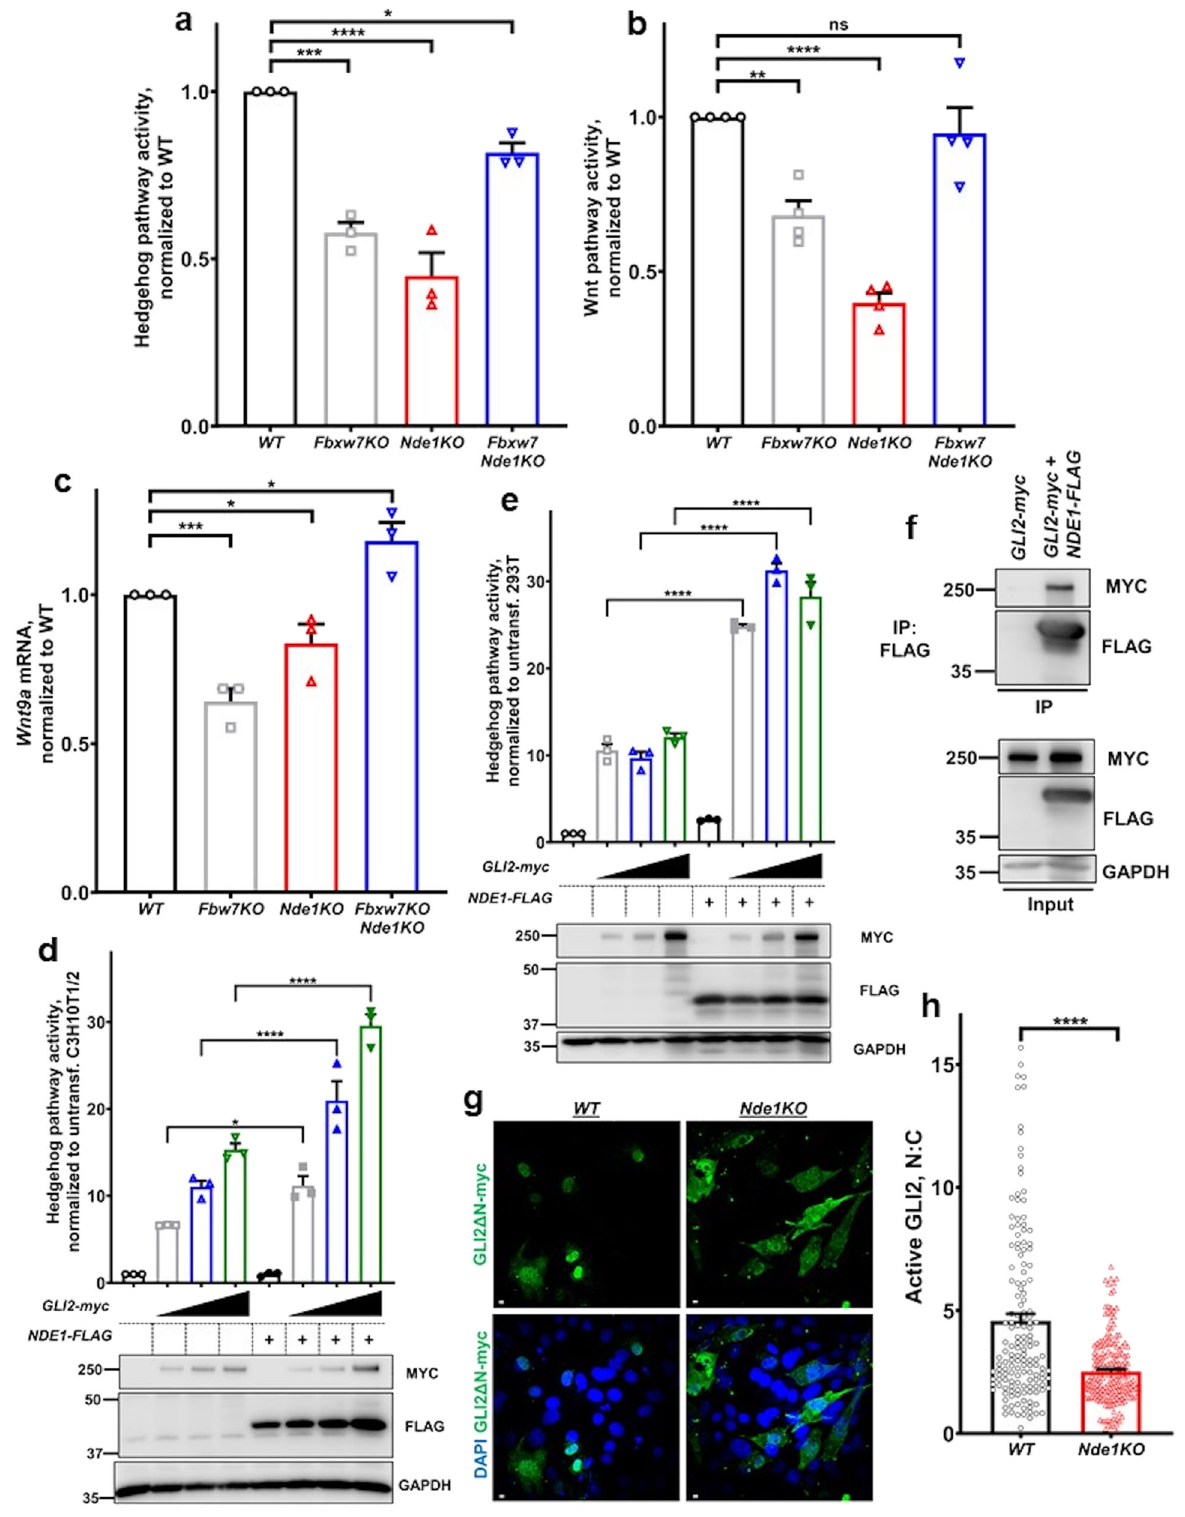
the Hedgehog pathway for the presence of optimal FBW7 phosphodegrons, we identi fi ed Fused and TALPID3 as potential targets. We proceeded with TALPID3, because it had four opti- mal FBW7 phosphodegrons (Fig. 7d). In addition, TALPID3 is required for early stages of cilia formation and organization of transition fi bers to assemble the ciliary gate at the base of the cilium 30 , which would be consistent with the small but signi fi cant